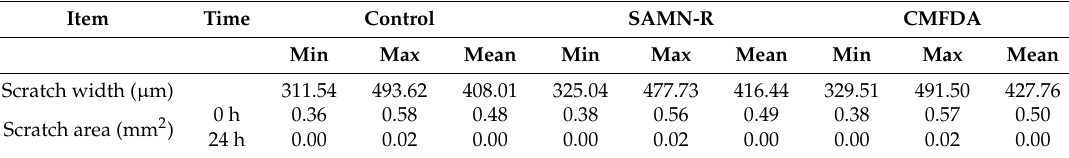
Table 1. Size values of the open area of narrow scratch in the wound healing assay